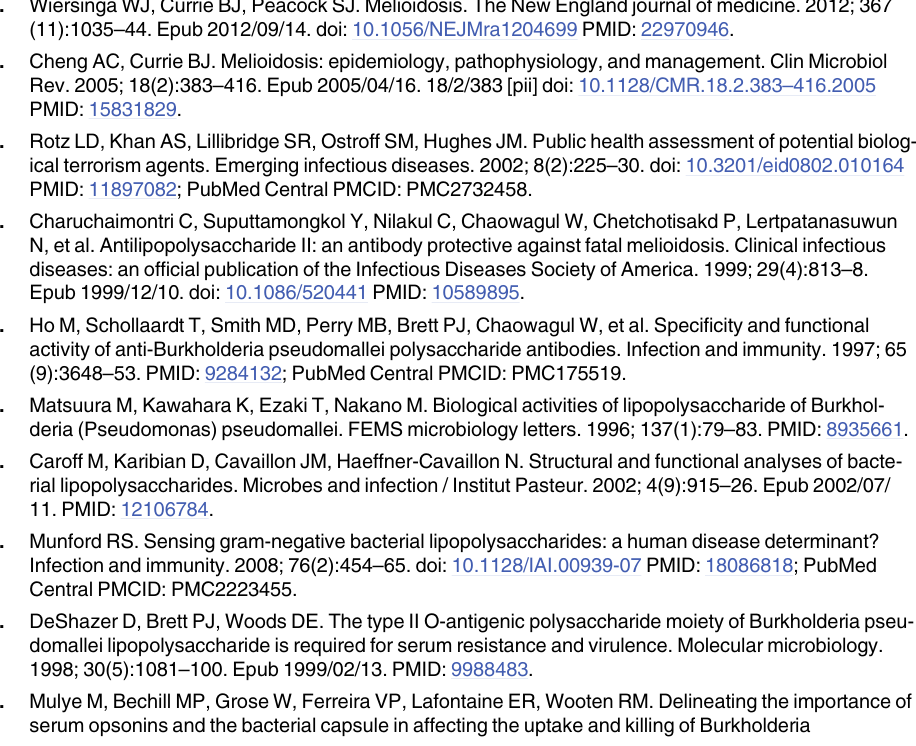
S2 Fig. Calculated m/z values for proposed structures of substituted lipid A backbone. (TIFF) S3 Fig. Lipoprotein lipase treatment does not significantly alter TLR-2 signalling of B . pseu- domallei -LPS. Human Embryonic Kidney (HEK)-293 cells, stably transfected with either CD14-TLR2 or CD14-TLR4/MD2 were stimulated with purified LPS of B . pseudomallei 1026b (100 ng/ml), LPS of E . coli 0111:B4 (100 ng/ml), PAM3CSK4 (100 ng/ml) or DMEM+ 10% FCS. Subsequently, lipoprotein lipase (200 or 2000 ng/ml) was added to the culture. 24h post- stimulation supernatant was collected and interleukin (IL)-8 was measured by ELISA (n = 4). Data are presented as means ± SEM and were analysed by Kruskall- Wallis analysis followed by Mann-Whitney- U tests. (cid:1) P < 0.05 compared to control.